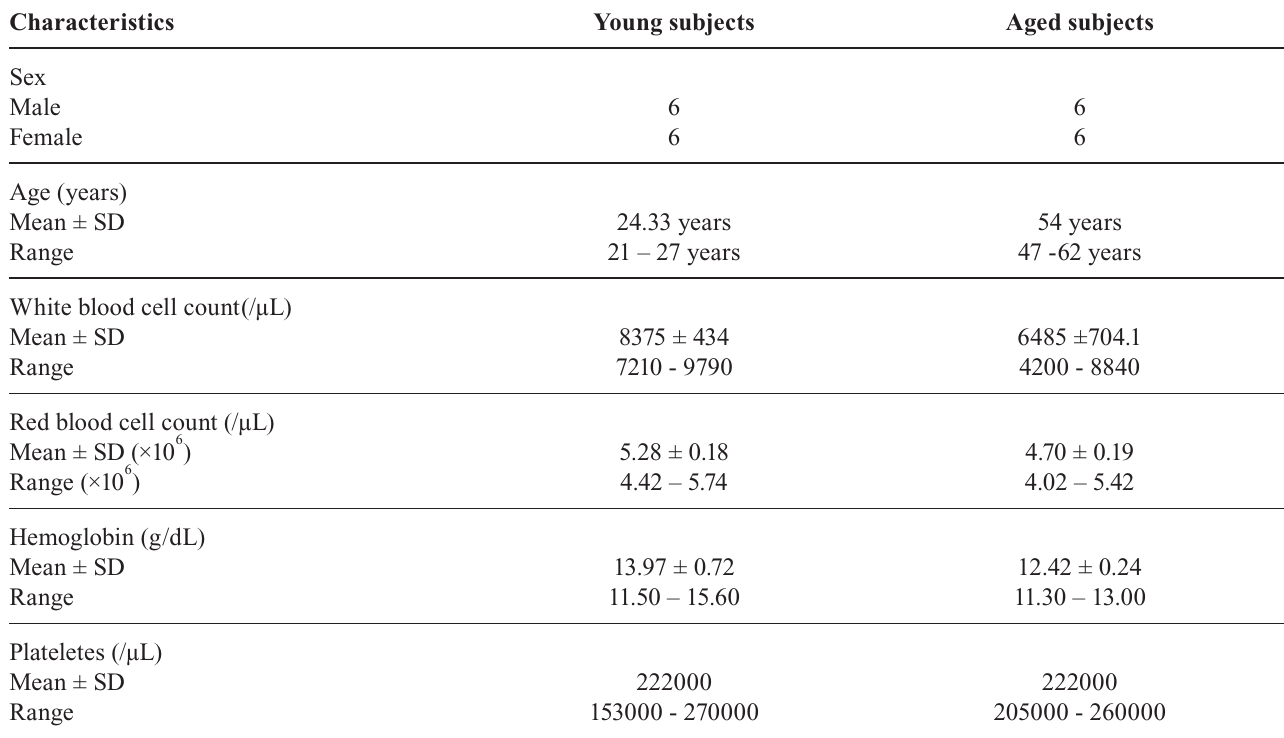
TABLE I - D emographic characteristics of study subjects